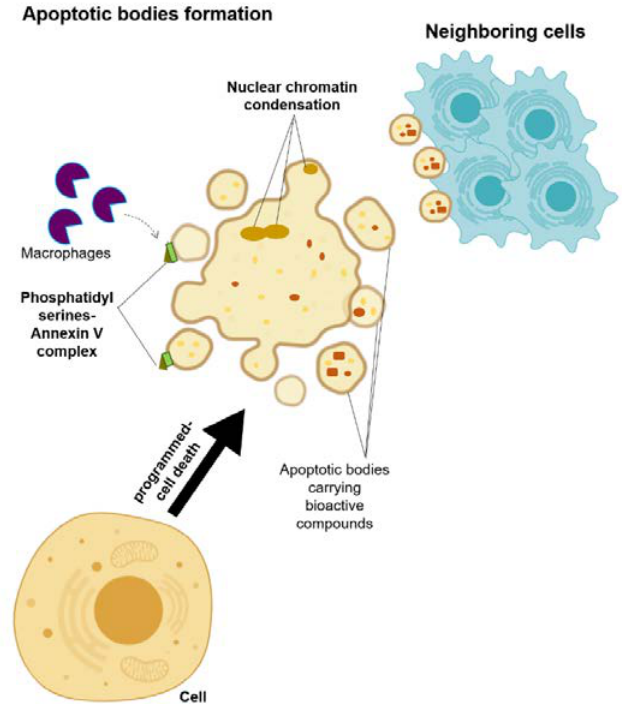
Figure 3. Schematic representation of the microvesicle biogenesis.